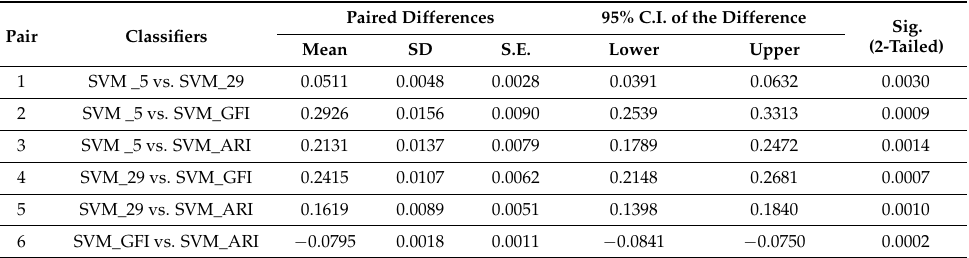
Table 7. Paired sample t test of the specificity of SVM